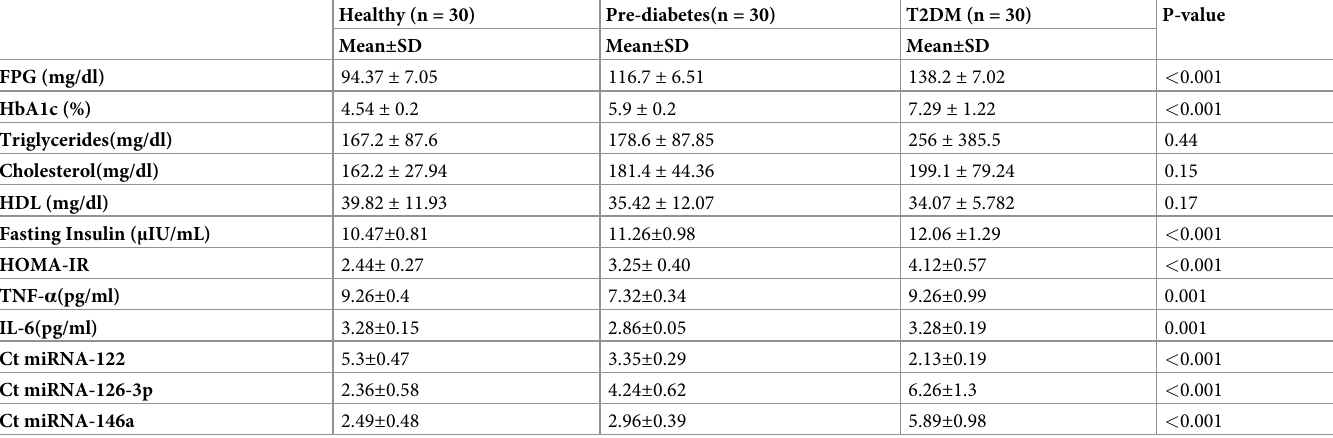
Table 1. Biochemical parameters of the studied